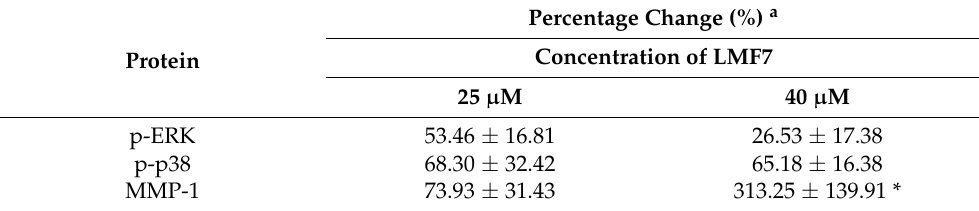
Table 6. Percentage change of p-ERK, p-p38 and MMP-1 expression in PM-induced HaCaT cells treated with liposomal morin formulation